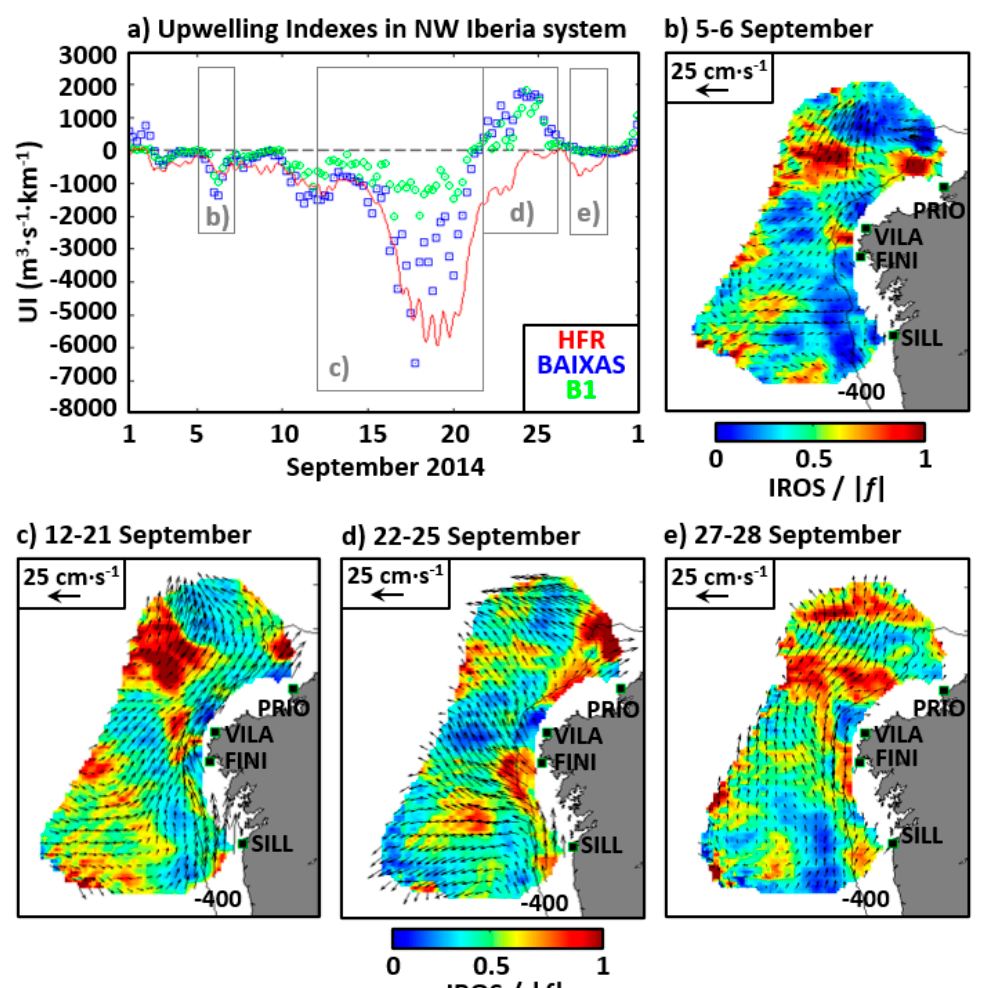
Figure 14. ( a ) Temporal evolution of hourly UI HFR (red line) and 6-hourly UI BAIXAS (blue squares) and UI B1 (green dots) during September 2014. Gray boxes indicate four selected UPW and DOW episodes. ( b – e ) Maps of time-averaged circulation and Instantaneous Rate of Separation (IROS) for each specific event. Bathymetric contour shows depth at 400 m. IROS magnitudes are normalized by the absolute value of the Coriolis parameter, f .